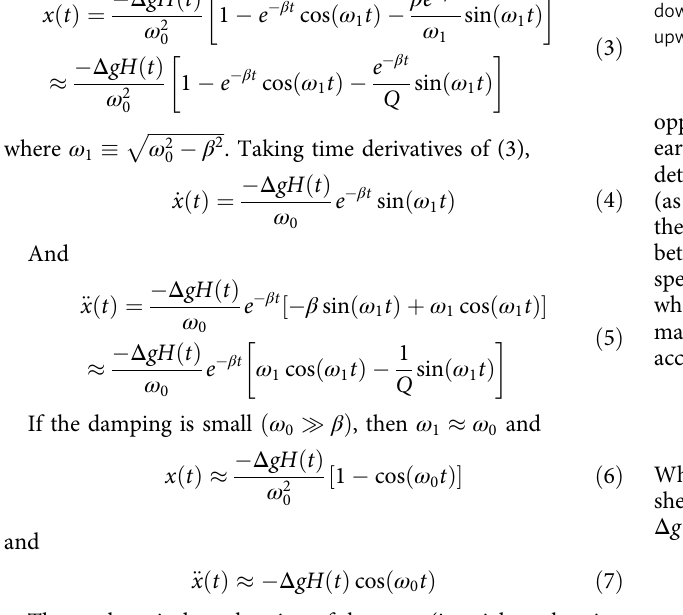
Where (cid:7) is the convolution operator. For short times after the earthquake origin, a Taylor expansion of the cosine can be used to approximate (10) as